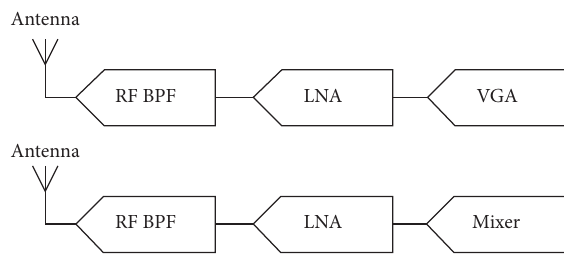
Figure 1: The main blocks in receiver and transmitter architecture.